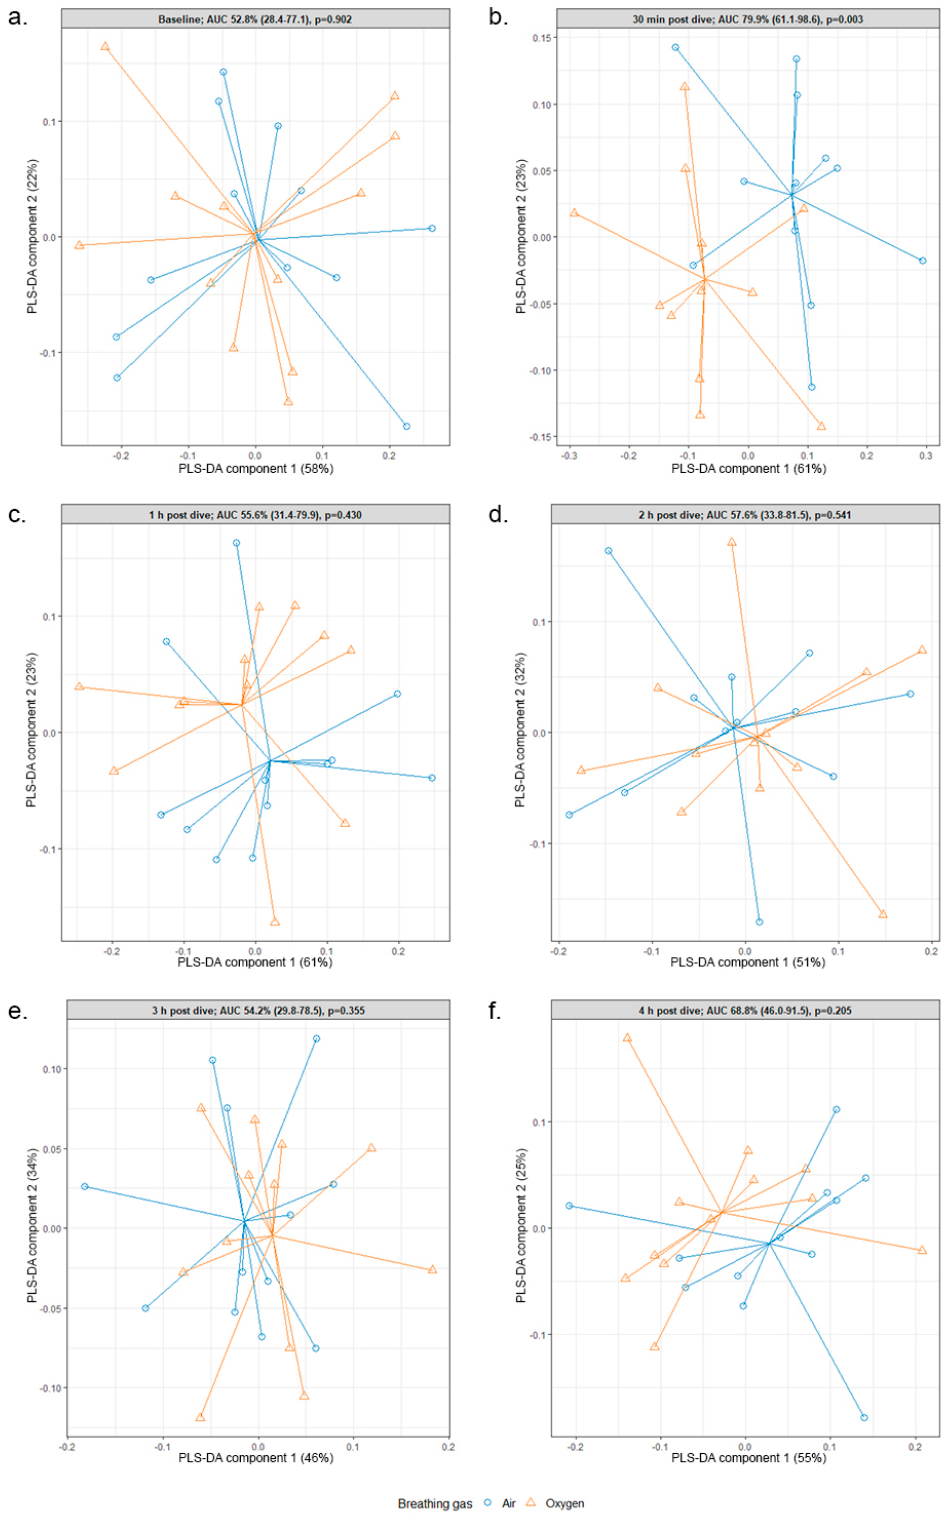
Figure 1. Partial least squares discriminant analysis of the electric nose (eNose) data. Oxygen dives are displayed in orange (triangles) and air dives in blue (circles). ( a ) 30 min pre dive; ( b ) 30 min post dive; ( c ) 1 h post dive; ( d ) 2 h post dive; ( e ) 3 h post dive; ( f ) 4 h post dive. The area under curve (AUC), including 95% confidence interval, as well as p -value are displayed in the title of the plot window. Note that as a result of the Mix0mics package and individual correction, the spider plots are mirrored from each other.